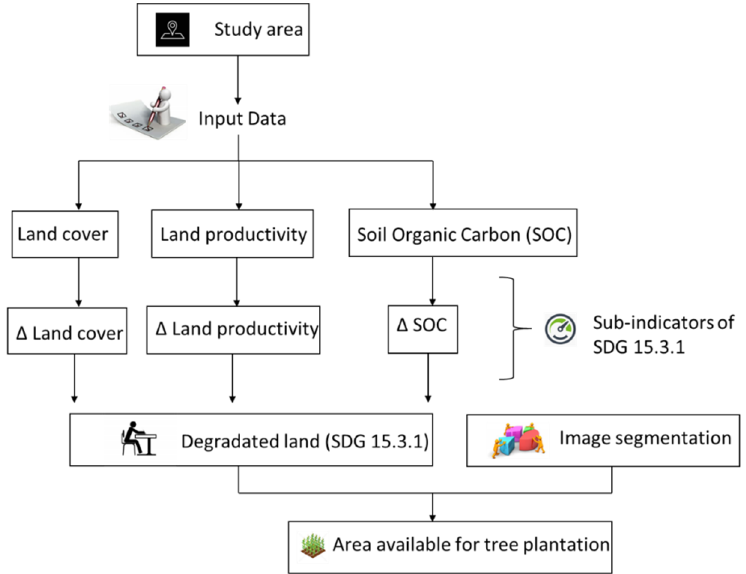
Figure 4. Workflow to delineate areas for tree plantation from degraded areas (SDG 15.3.1).